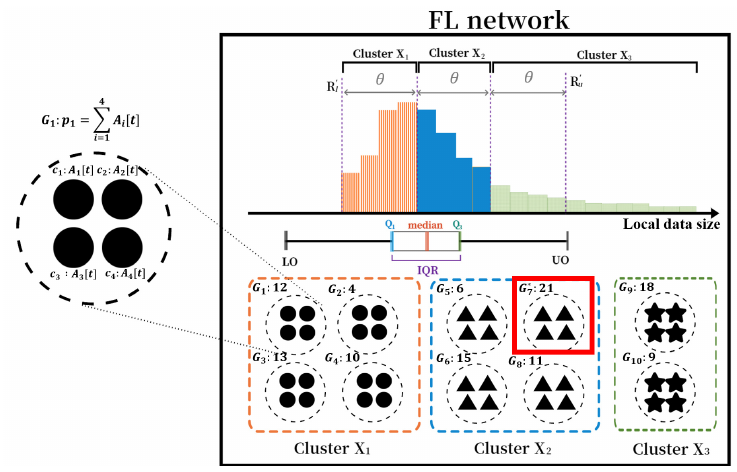
Figure 8. Example of